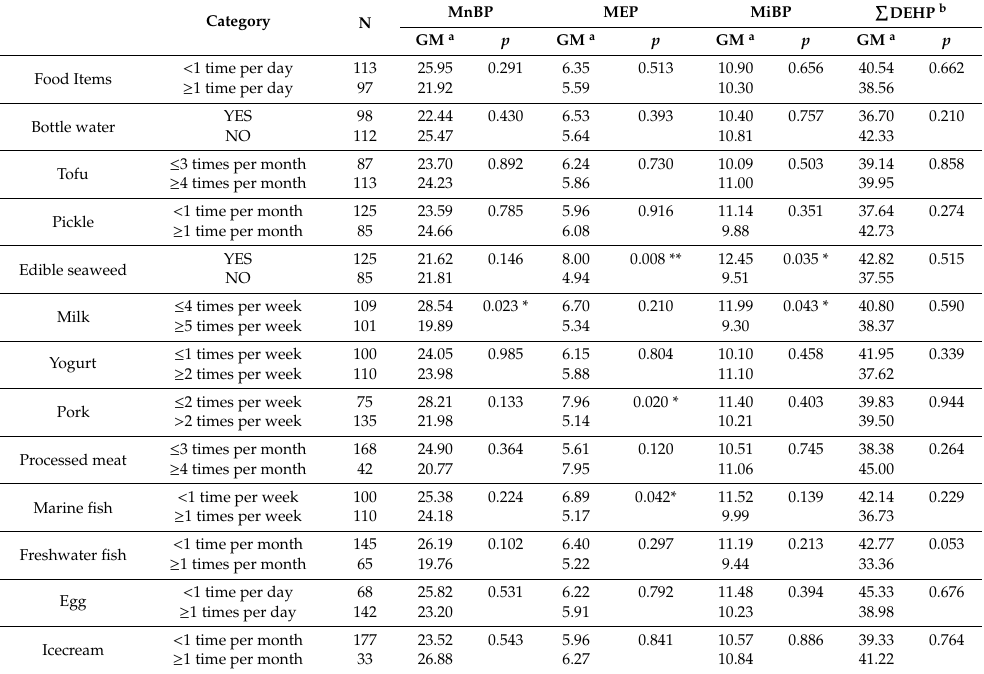
Table 4. Univariate analysis of urinary phthalate metabolite concentrations based on the food